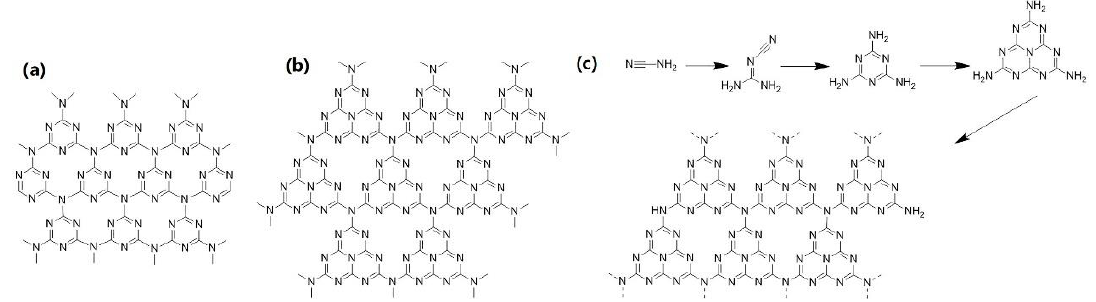
Figure 10. Triazine ( a ) and tri-s-striazine ( b ) allotropes units of g-C 3 N 4 ; ( c) The synthesis of g-C 3 N 4.